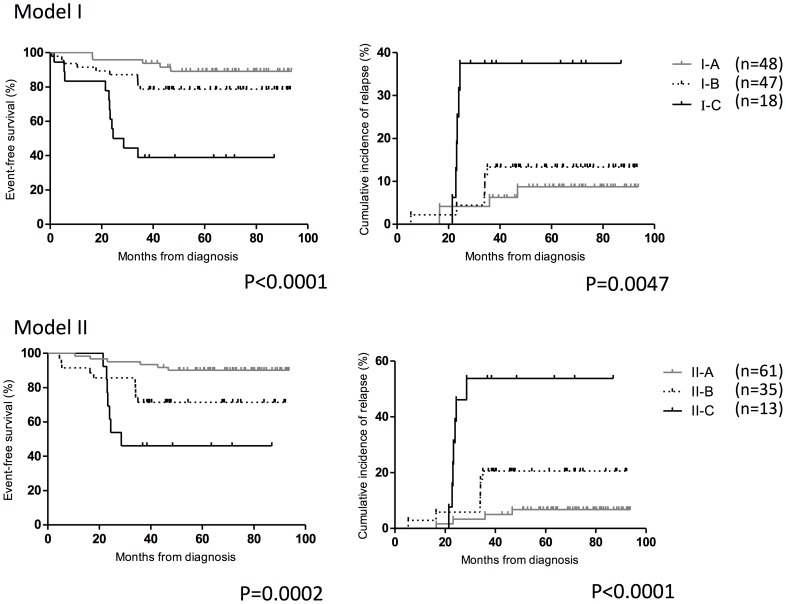
Prognostic significance of MRD as detected by FCM at day 15 and day 33.Event-free survival (left) and incidence of relapse (right) of patients stratified according to FCM MRD Model I (upper panel) and Model II (lower panel).